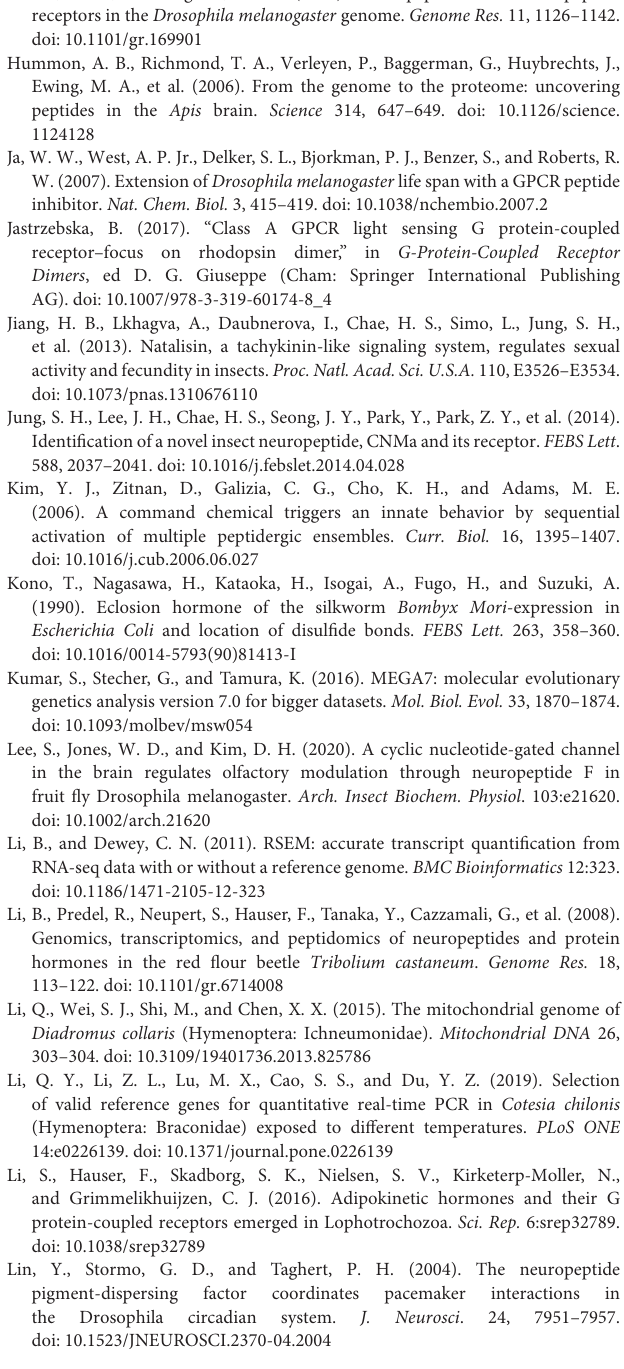
Supplementary Figure 3 | The qPCR analysis of relative expression levels of neuropeptide genes and neuropeptide receptor genes in different tissues. VG, venom glands; SG, salivary glands; VGC, carcass of female adults without their venom gland; SGC, carcass of larvae without salivary glands. The pink dotted line represents the FPKM (fragments per kilobase of transcript per million) value, and the relative expression levels from the qPCR are depicted in represented by the light blue